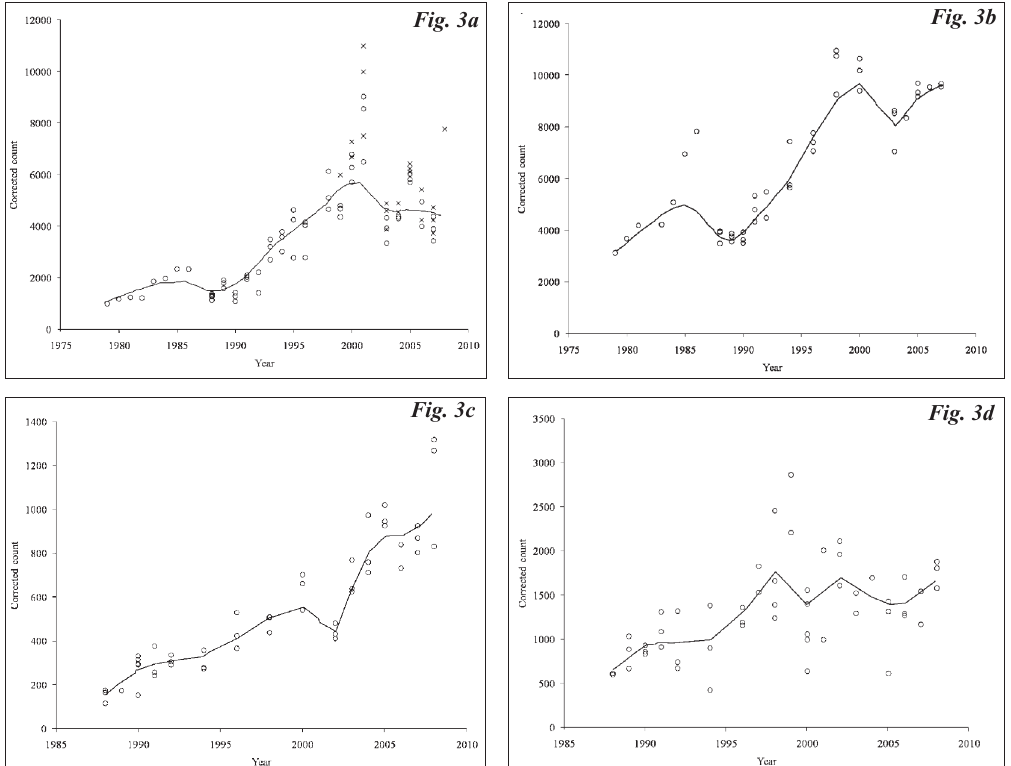
Fig. 3. Trends in number of seals in the 4 subpopulations; Skagerak (a), Kattegat (b), western Baltic (c), and the Limfjord (d). X-axis shows year of survey and Y-axis the estimated popula- tion size corrected for the proportion of seals in the water. In addition to the graphic point presentation of the temporal trend of the population estimates Lowess smoother curves were applied to the four regions using a 25% smoothing factor. Crosses in Figure 3a is abundance including Oslo Fjord,